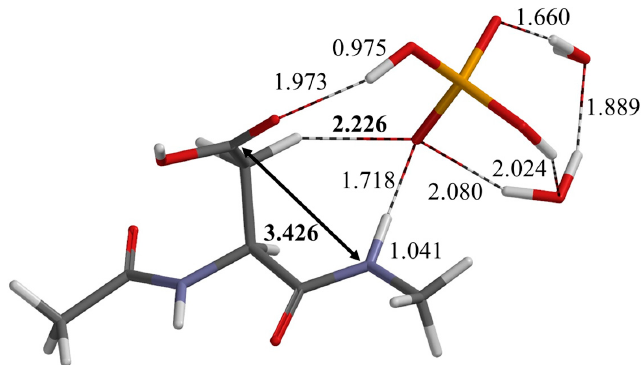
Figure 3. The geometry of the reactant complex (RC). This complex is formed between the model compound (Figure 1), a H 2 PO 4 − ion, and two water molecules. Selected interatomic distances are shown in Å. Grey: carbon; white: hydrogen; blue: nitrogen; red: oxygen; orange: phosphorus.